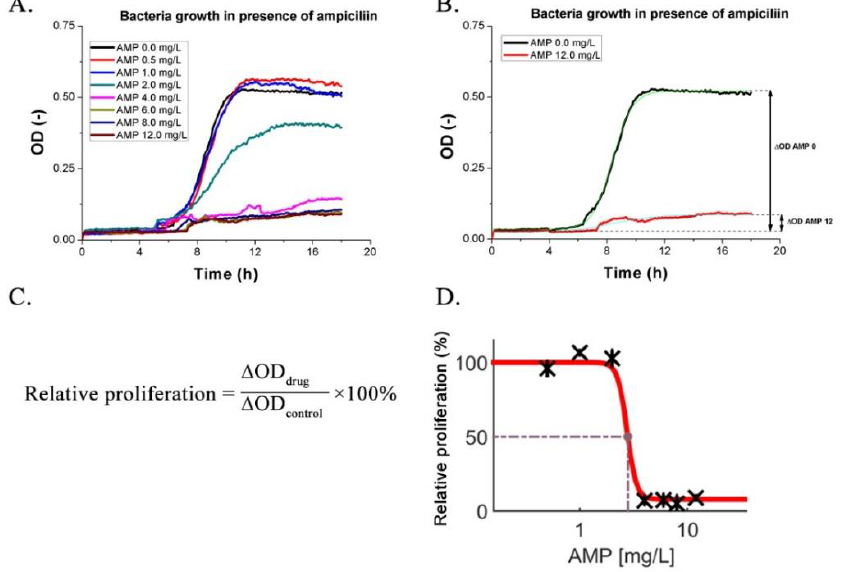
Figure 5. Top: Growth curves of bacteria in presence of ampicillin at various concentrations. MIC (minimum inhibitory concentration) determination is a choice of the lowest concentration that inhibits growth (MIC = 4.0 mg/L). ( A ). Each growth curve was fitted with a sigmoidal dose–response function ( B ). The ΔOD (change in optical density) is a difference between the baseline and the highest recorded response inferred from the fit. Bottom: Calculation of the drug impact on the bacteria population. Proliferation was calculated as the ratio of the signal from the investigated well to a control well with bacteria without a drug ( C ). A dose–response plot is shown in the right without first point, which is control at concentration zero ( D ).